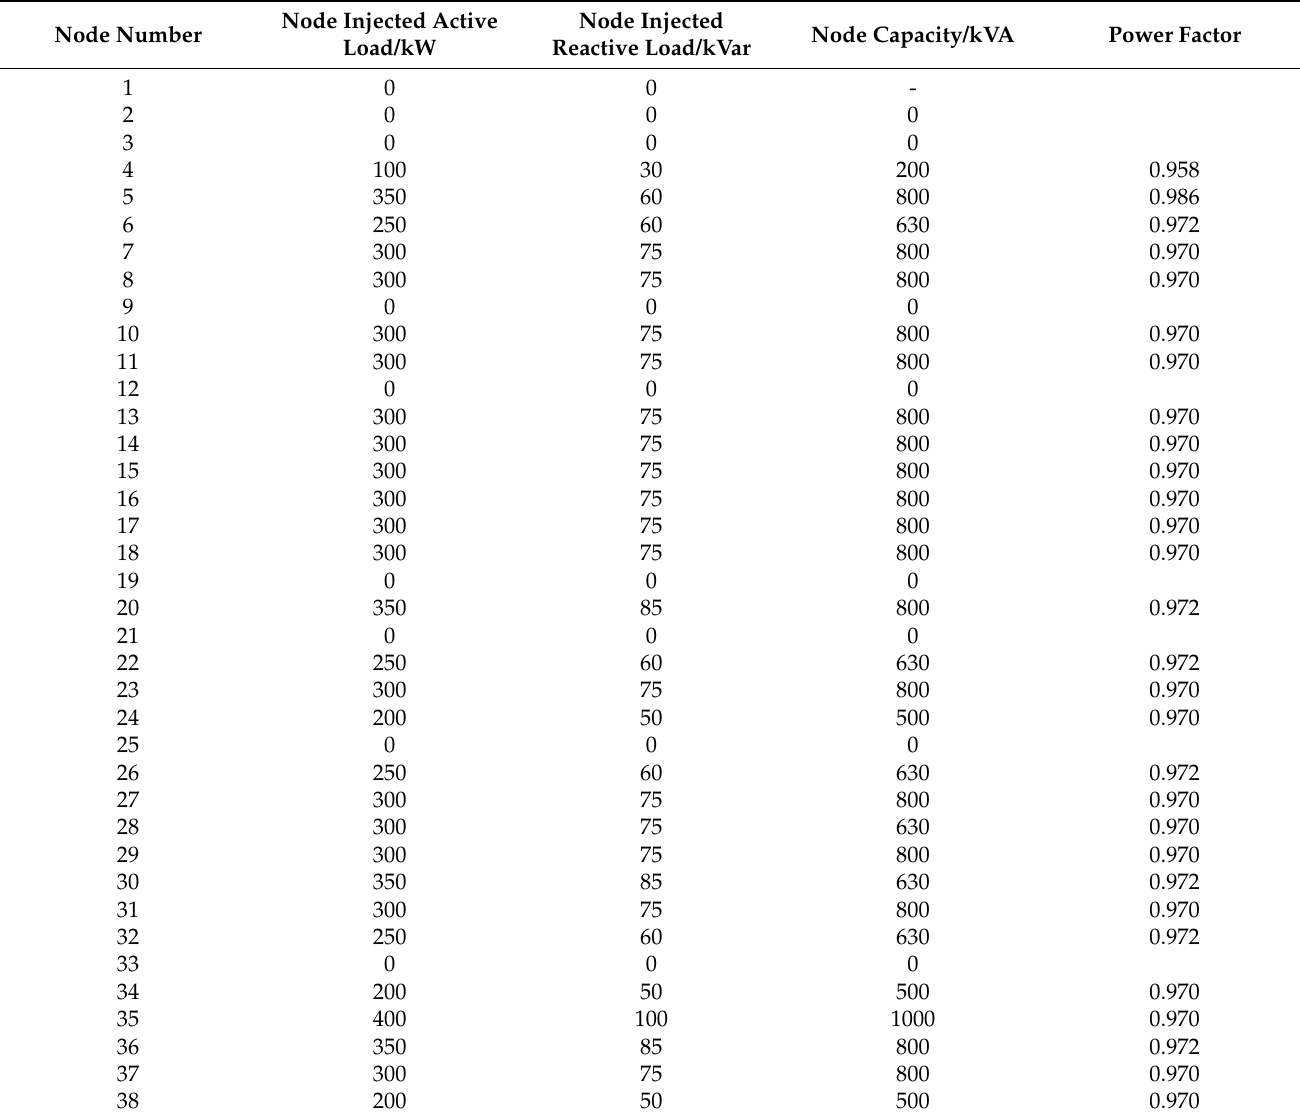
Table A1. Load parameters of each node.